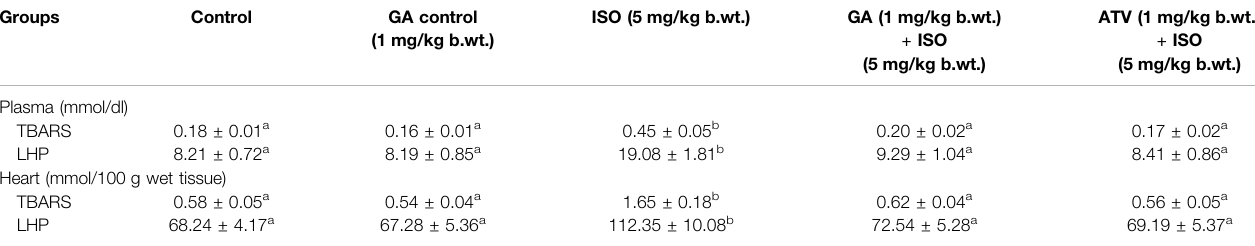
TABLE 3 | Effect of GA on the levels of vitamin C, vitamin E and GSH in the plasma and heart of control and ISO-induced rats. Groups Control GA control (1 mg/kg b.wt.)